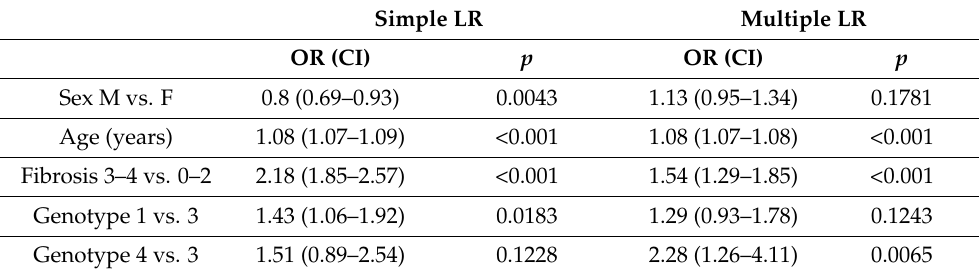
Table 3. Factors associated with the prevalence of hypertension—logistic regression.